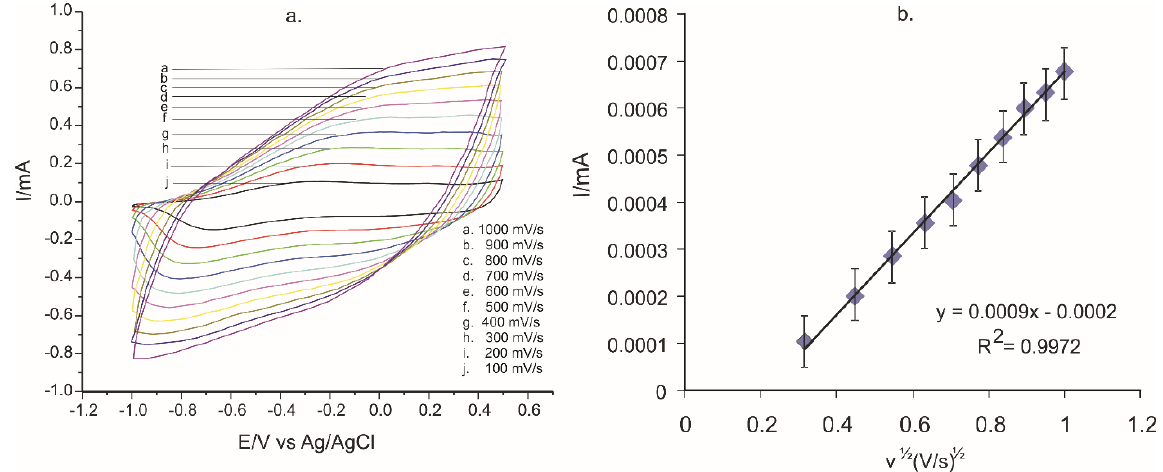
Figure 10. ( a ) CVs of the PPy/FeCN-SPCE sensor immersed in the KCl 0.1 M and 10 − 3 M L-Tyr solution, at scan rates between 0.1 and 1.0 V×s − 1 . ( b ) Linear fitting curves between I pa and square root of scan rate.